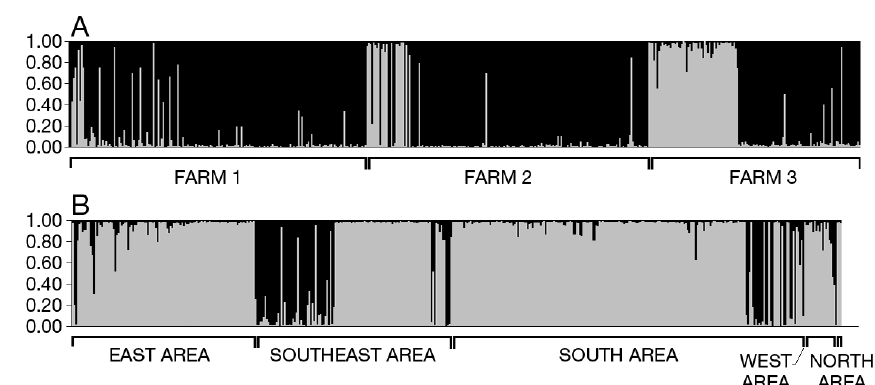
Fig. 4. Summary of STRUCTURE analysis with 2-population model. All samples were analysed together but here are separated into (A) farm and (B) wild, ordered by sam- pling location and collection date. Each bar represents an individual and the height of the bar is the probability of assignment to either farm origin (black) or wild origin (grey)